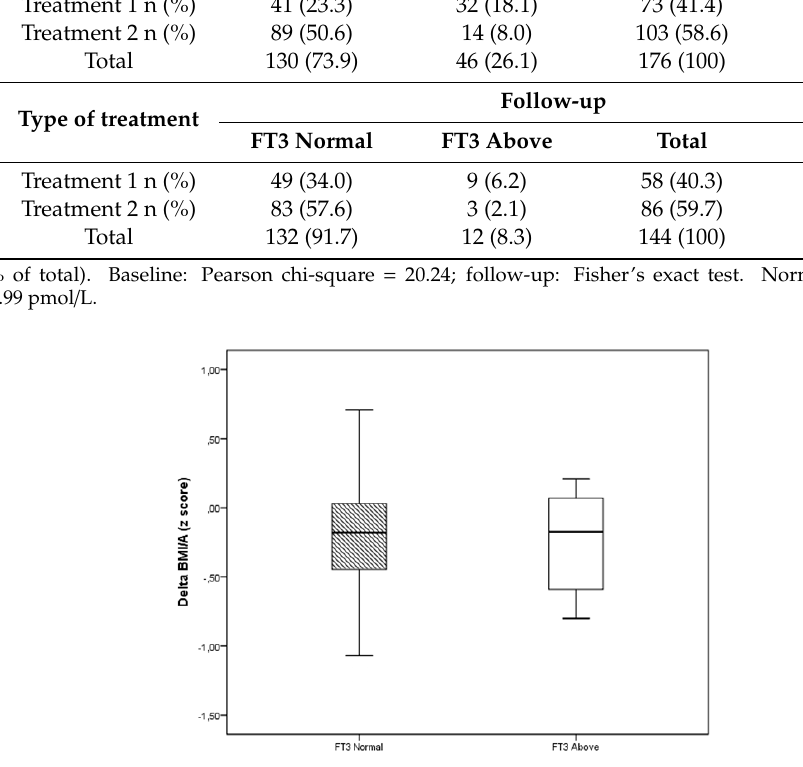
Table 3. Distribution of individuals according to FT3 values a .